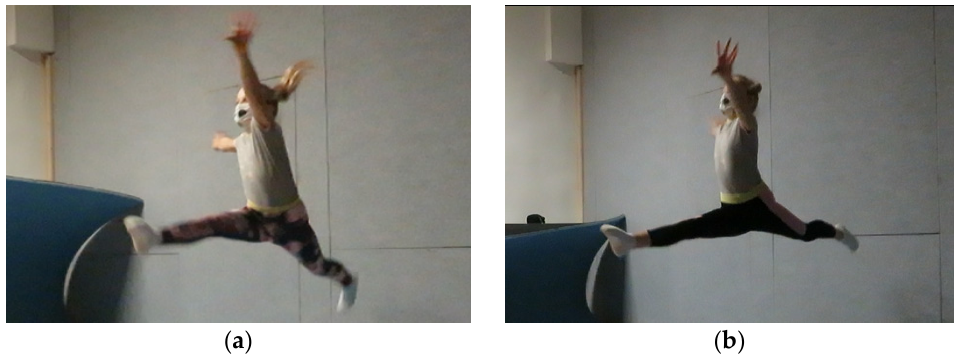
Figure 4. The biggest progress in culmination in IP2: ( a ) pretest; ( b ) posttest.